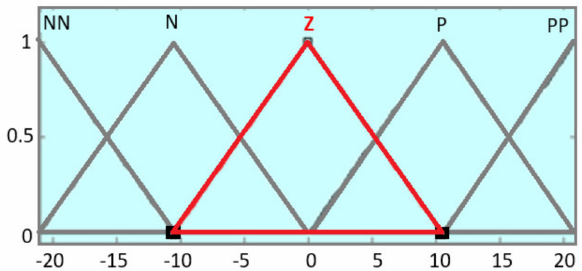
Figure 6. Output membership function for the Mamdani Fuzzy–PD controller.